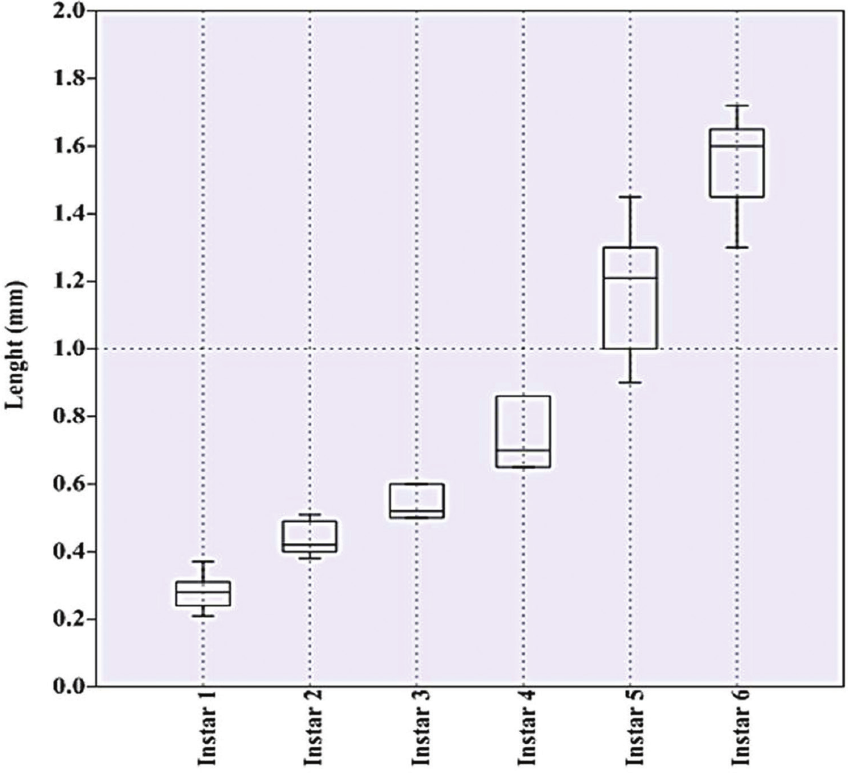
Figure 7. Box-whisker plot of total length variation with reference to each larval instar